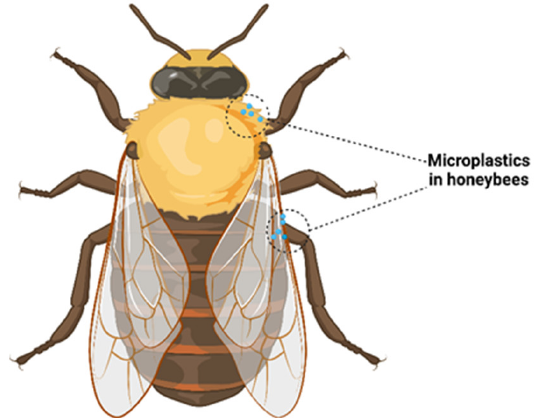
Figure 4. The presence of microplastics on the surface of a bee’s body, especially on the edge of the wings and the head. Created with BioRender.com.